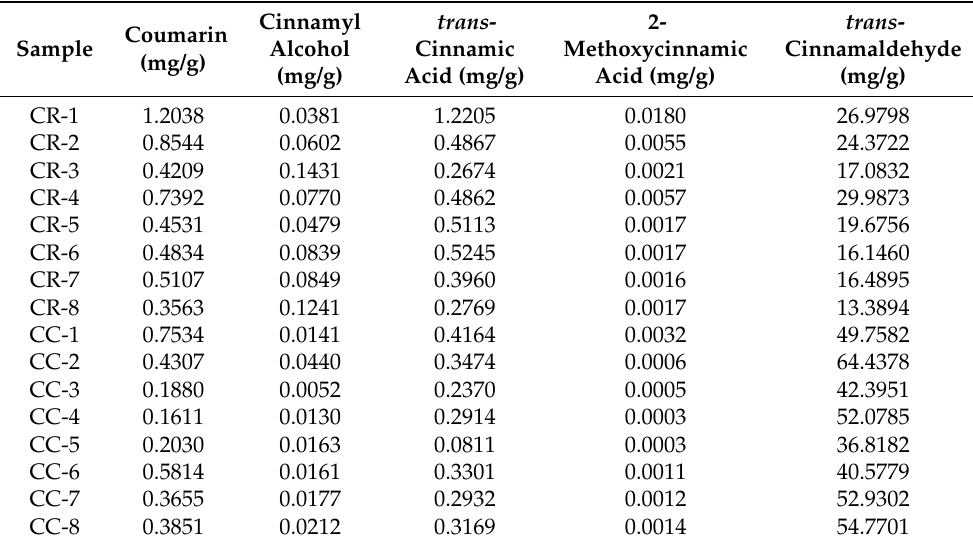
Table 3. The contents of 5 analytes in 8 batches of CR and